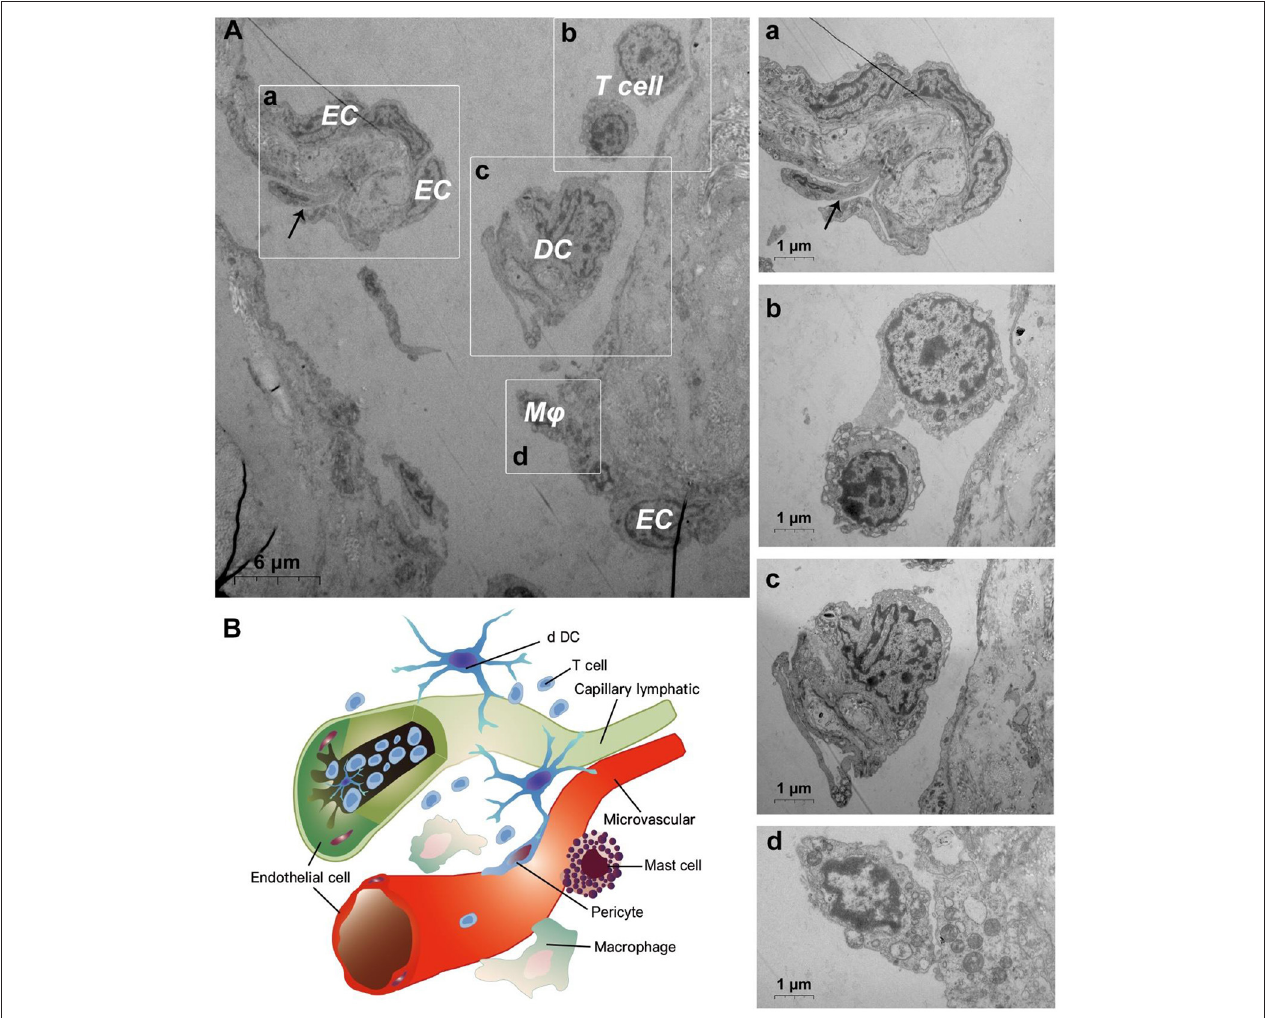
FIGURE 4 | Ultrastructural analysis of lymphatic vessels at the steady state via TEM. (A) The ultrastructure of lymphatic vessel and surrounding cells in the steady state; (a) is the enlargement of lymphatic endothelium in (A) ; (b) is the enlargement of T cells in (A) ; (c) is the enlargement of the dendritic cell in (A) ; (d) is the enlargement of the macrophage in (A) ; (B) Pattern diagram of DMUs in the steady state. EC, endothelial cell; M φ , macrophage; DC, dendritic cell; → , Imbricate overlap of endothelial cells. The scale bar (A) = 6 µ m; (a–d) = 1 µ